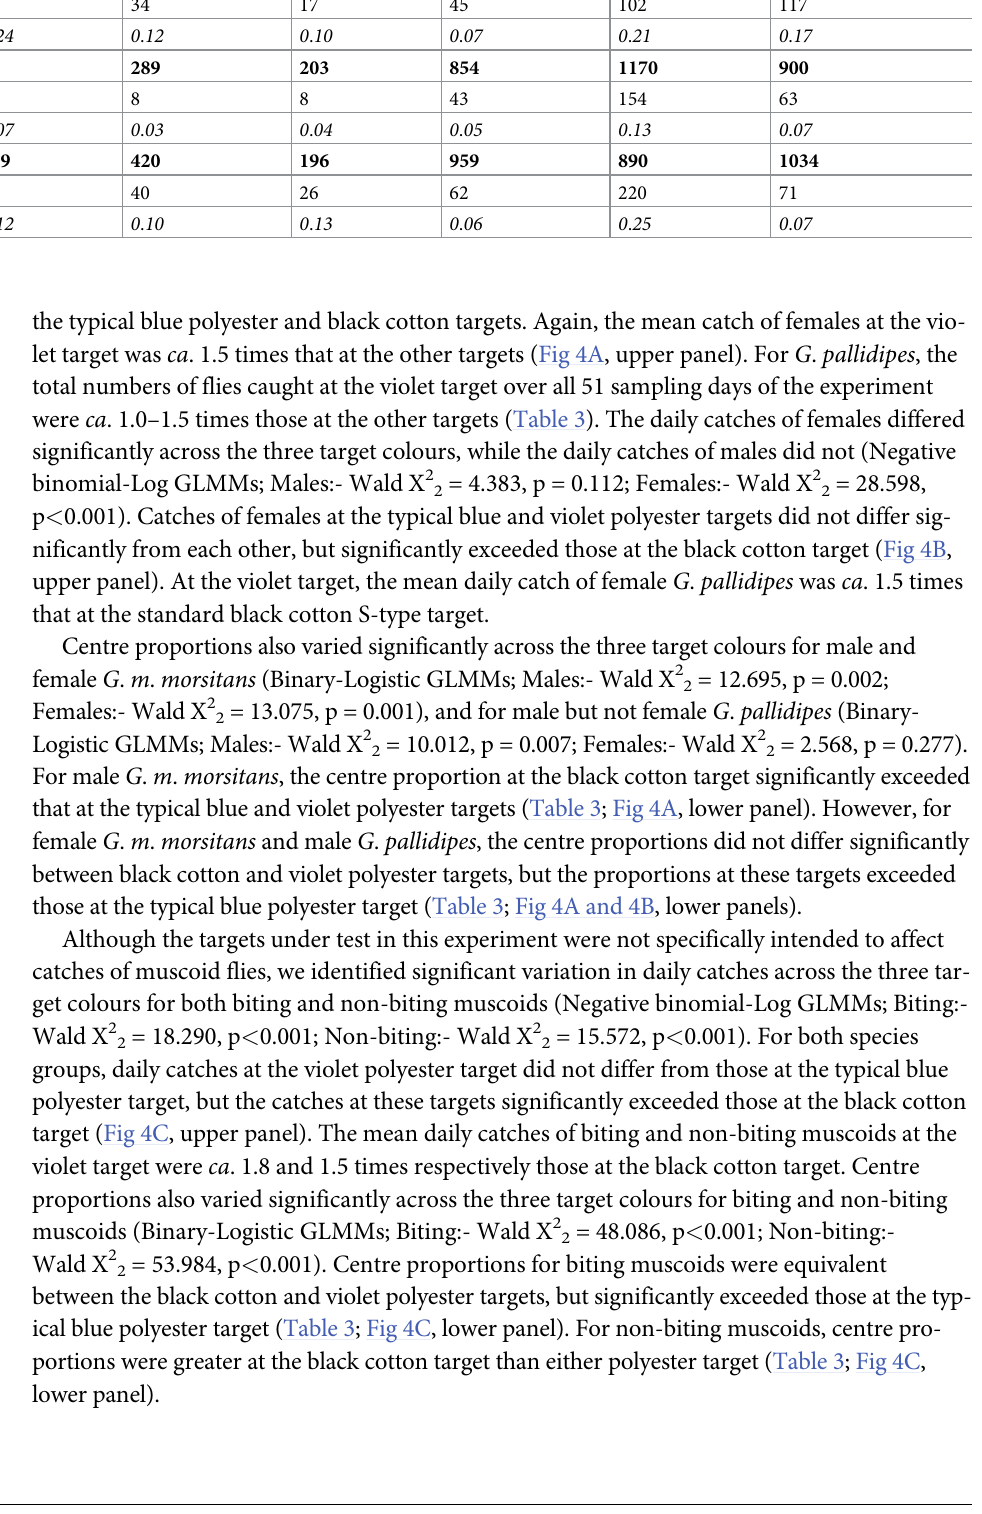
Table 3. Total numbers of flies caught over 51 sampling days of experiment 2, the number caught on the centre target panel, and that number expressed as a pro- portion of the